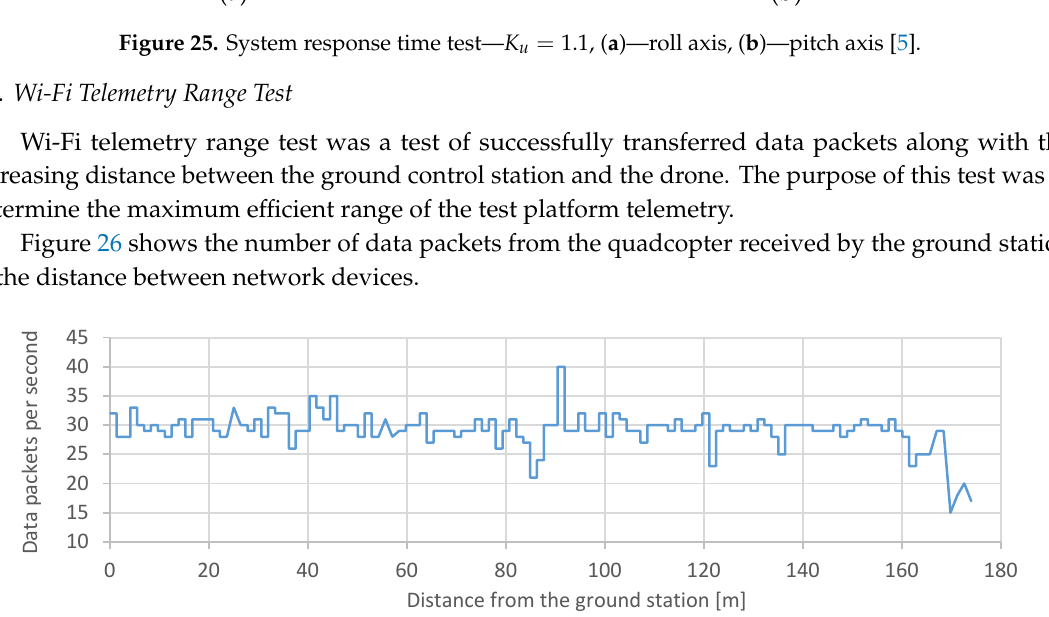
Figure 25. System response time test — 𝐾 𝑢 = 1.1 , ( a ) — roll axis, ( b ) — pitch axis [5].